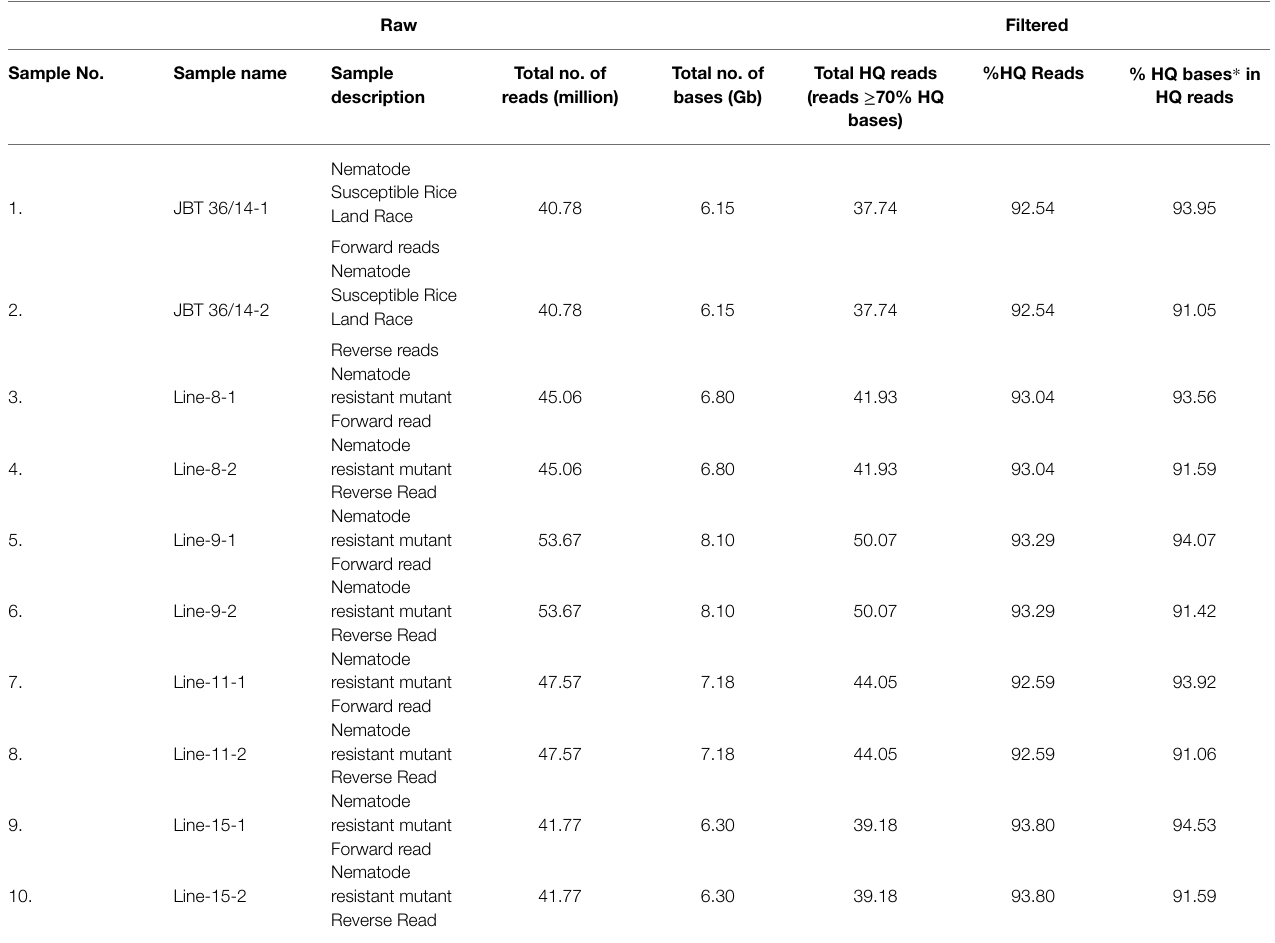
TABLE 1 | Raw data statistics of the sequenced rice lines. Raw Filtered Sample No.